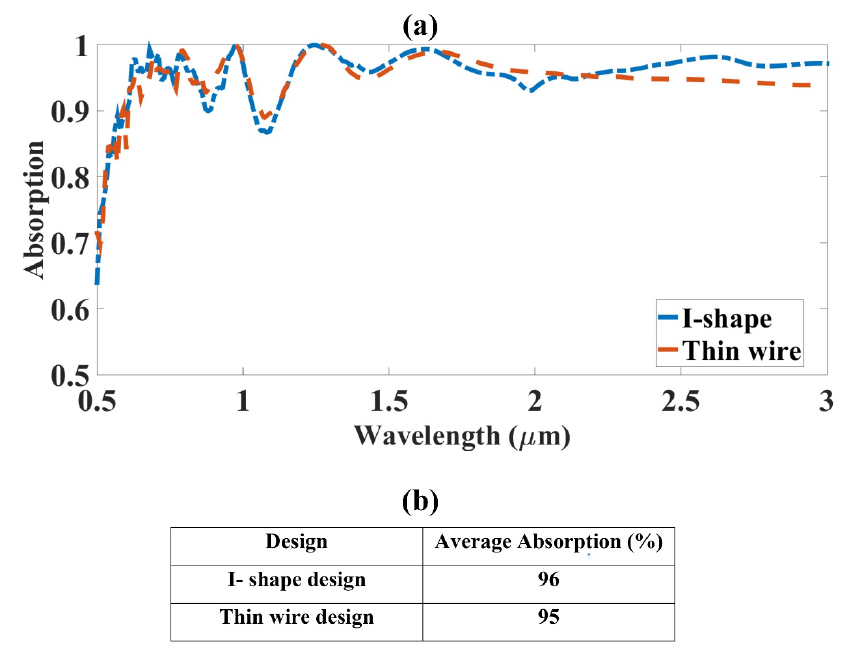
Figure 2. The metamaterial design comparative response for I-shape design and thin wire design is shown in ( a ) an absorption plot ( b ) and a comparative table with numerical data. The highest average absorption response is 96% for the I-shape metamaterial design.